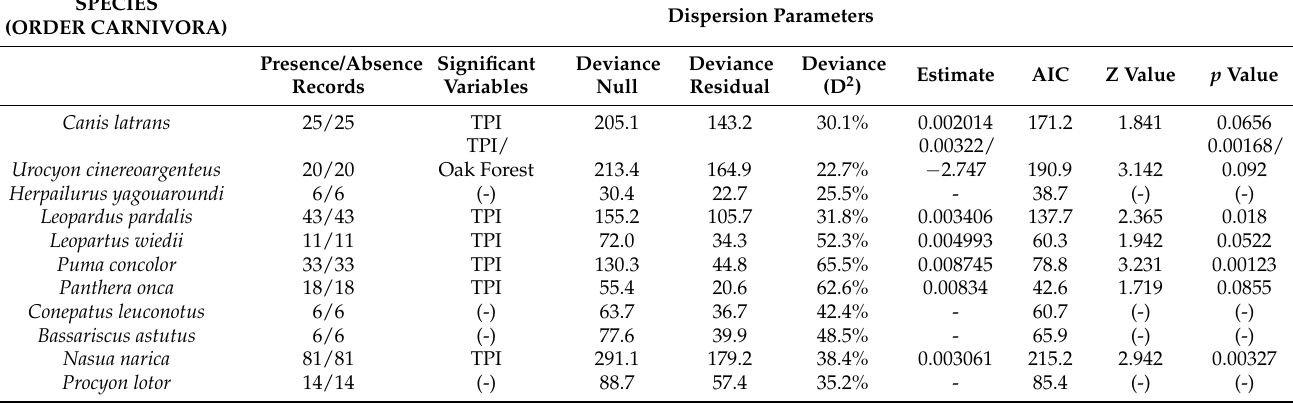
Table 4. Parameters obtained by generalized linear models (GLM) for estimating the habitat type/species